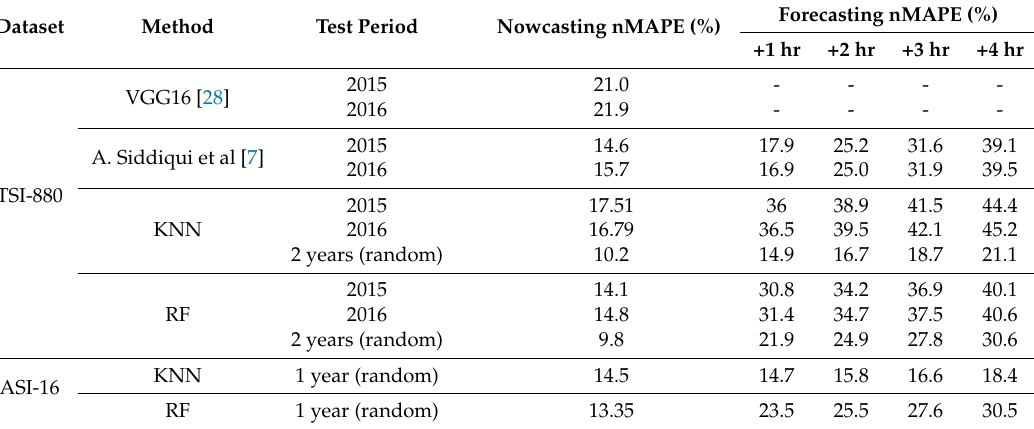
Table 1. nMAPE for nowcasting and forecasting results using different methods.